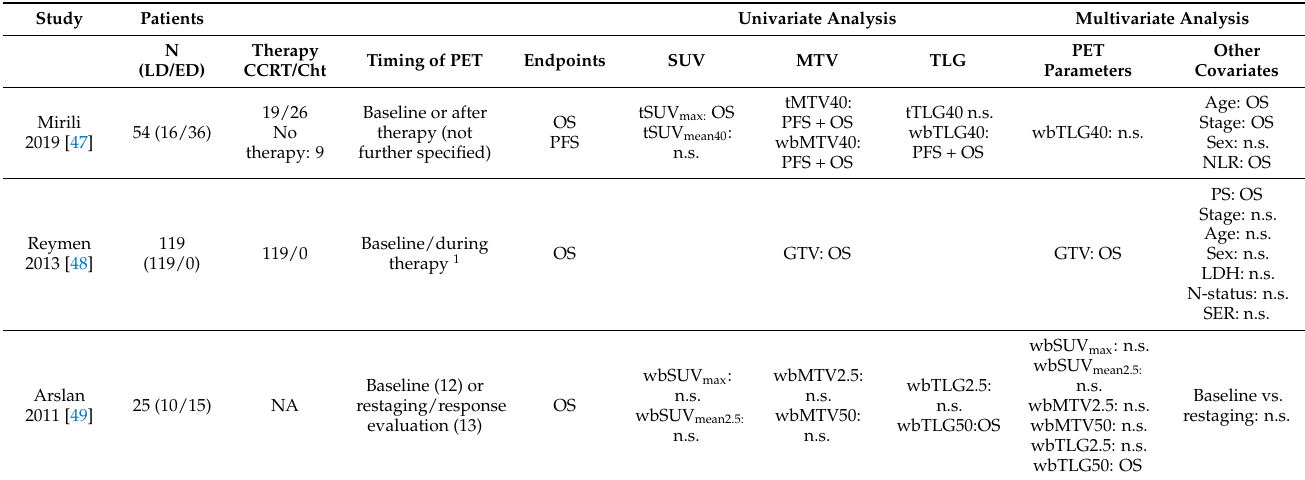
Table 5. Prognostic value of PET parameters in studies with PET at mixed treatment phases. Study